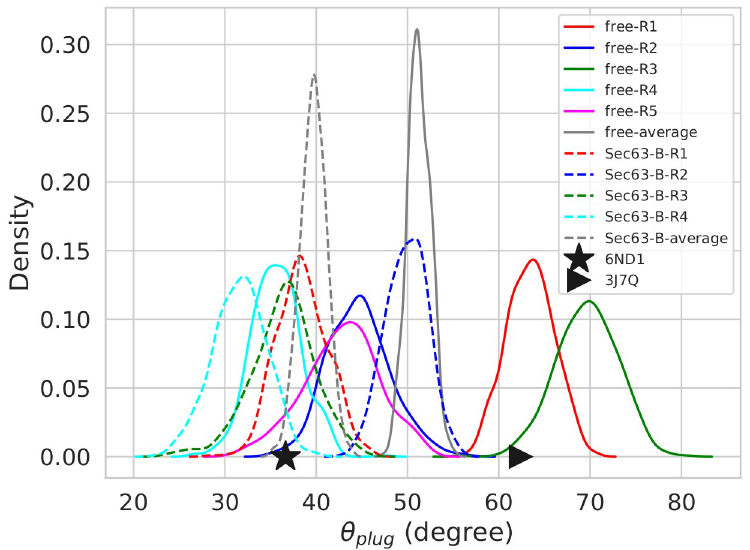
Fig 10. The probability distributions of θ values obtained from the last 50 ns of five MD simulation replicas plug (Ri, i = replica number). Solid and dashed lines represent simulations of the ‘free’ (free) and ‘Sec63-bound’ (Sec63-B) states, respectively. Black star and triangular symbols represent values in the experimental cryo-EM structures of Sec complex and ribosome-Sec61 complex, respectively. The plug region is missing in the cryo-EM structure of the open- state ribosome-Sec61 complex (PDB ID: